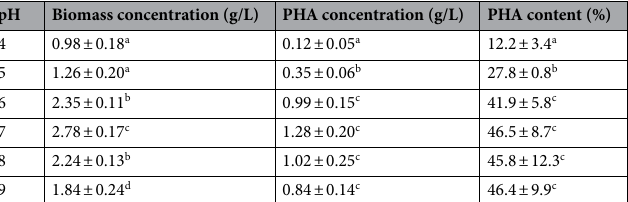
Table 2. Effect of pH on the growth and PHA synthesis of Pichia sp. TSLS24. In a column, data with different superscript are significant with P < 0.05.